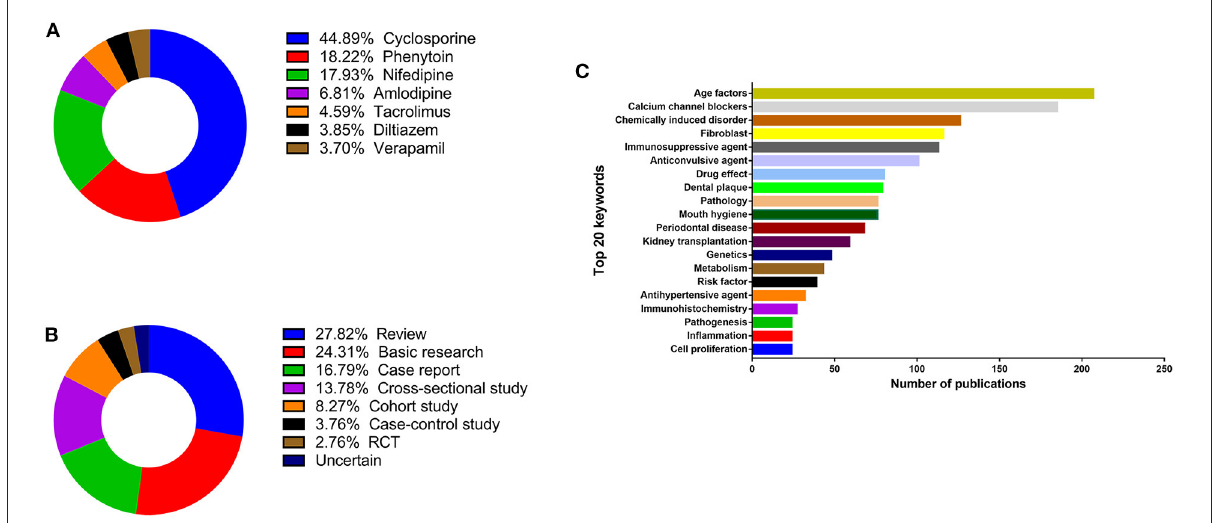
FIGURE2 Research trend and hotspots of DIGO. (A) The frequency of drug related to DIGO. (B) The frequency of study design. (C) Top-20 keywords.